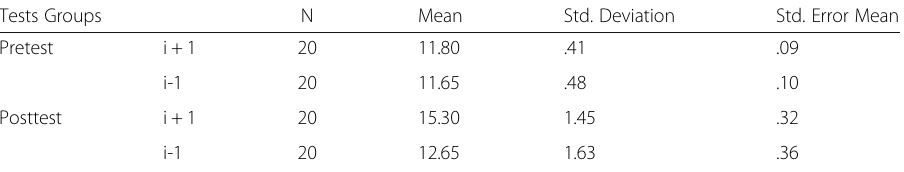
Table 2 Descriptive Statistics (Pre-test and Posttest of Both Groups) Tests Groups N Mean Std. Deviation